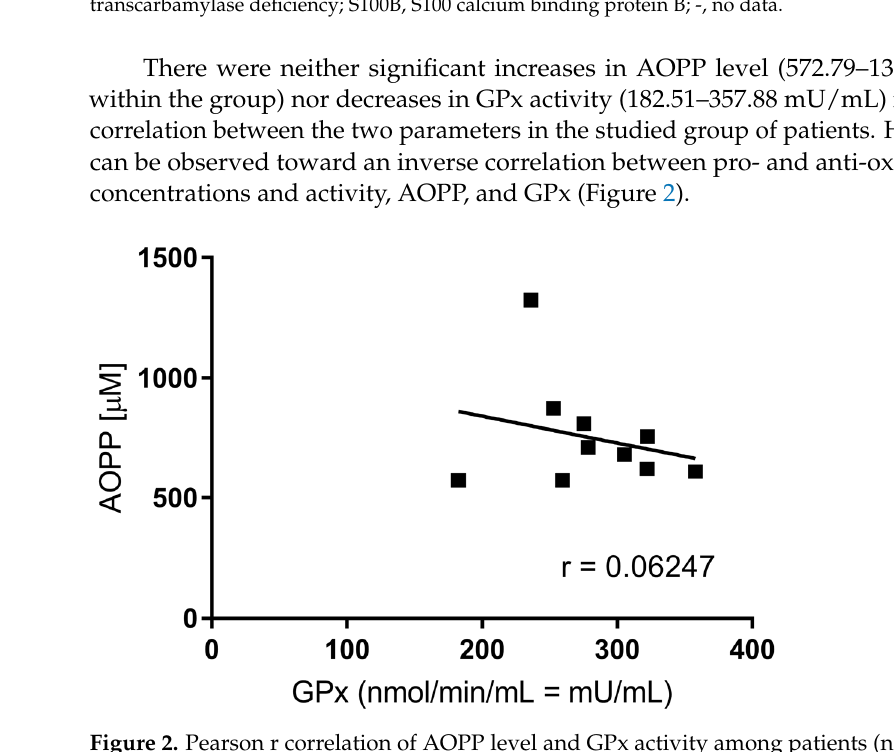
Figure 2. Pearson r correlation of AOPP level and GPx activity among patients (n = 11).